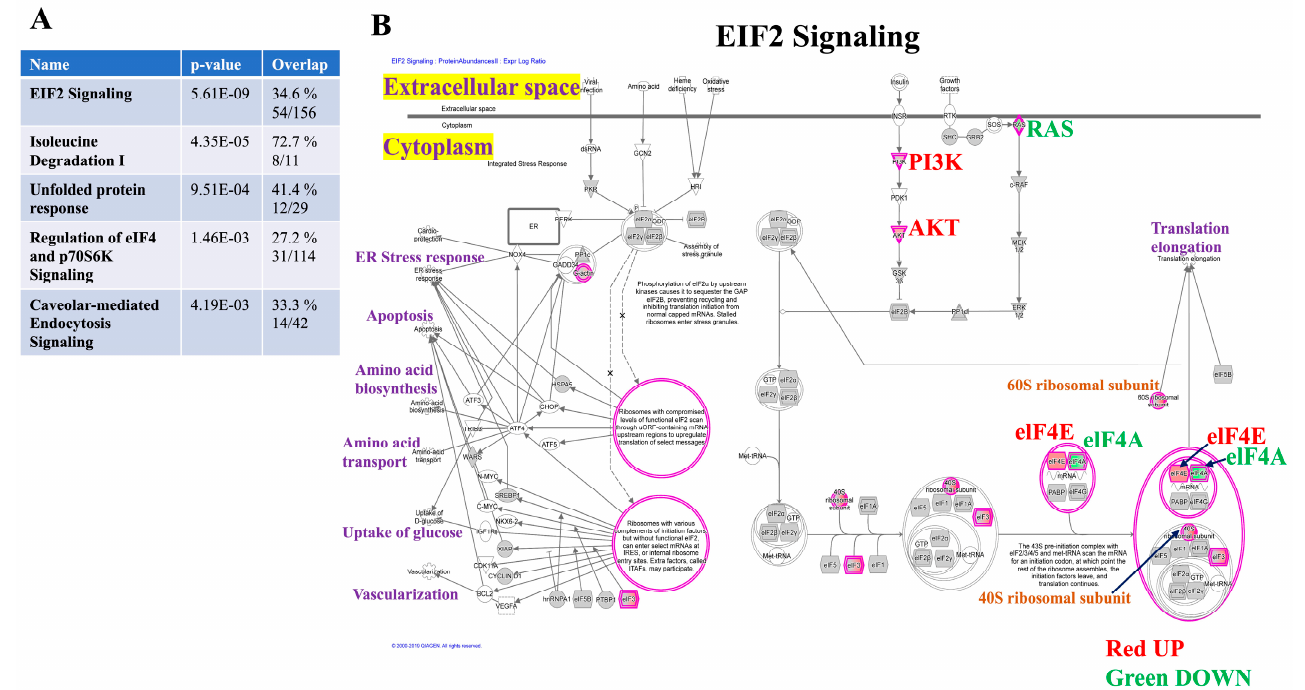
Figure 3. Canonical pathways identified by Ingenuity Pathway Analysis ( A ), Illustrated are the top five canonical pathways ( p < 0.05) based on 904 differentially expressed proteins in the mdig KO vs. WT MDA-MB-231 cells. ( B ), Canonical pathway analysis revealed the eukaryotic initiation factor 2 signaling pathway among the topmost canonical pathways enriched upon mdig KO. The EIF2 Signaling has been elaborated by showing the upregulated and downregulated proteins and their cellular localization. Nodes represent molecules in a pathway, whereas the biological relationship between nodes is represented by a line (edge). Edges are supported by at least one reference in the Ingenuity Knowledge Base. The intensity of color in a node indicates the degree of up (red) or down (green)